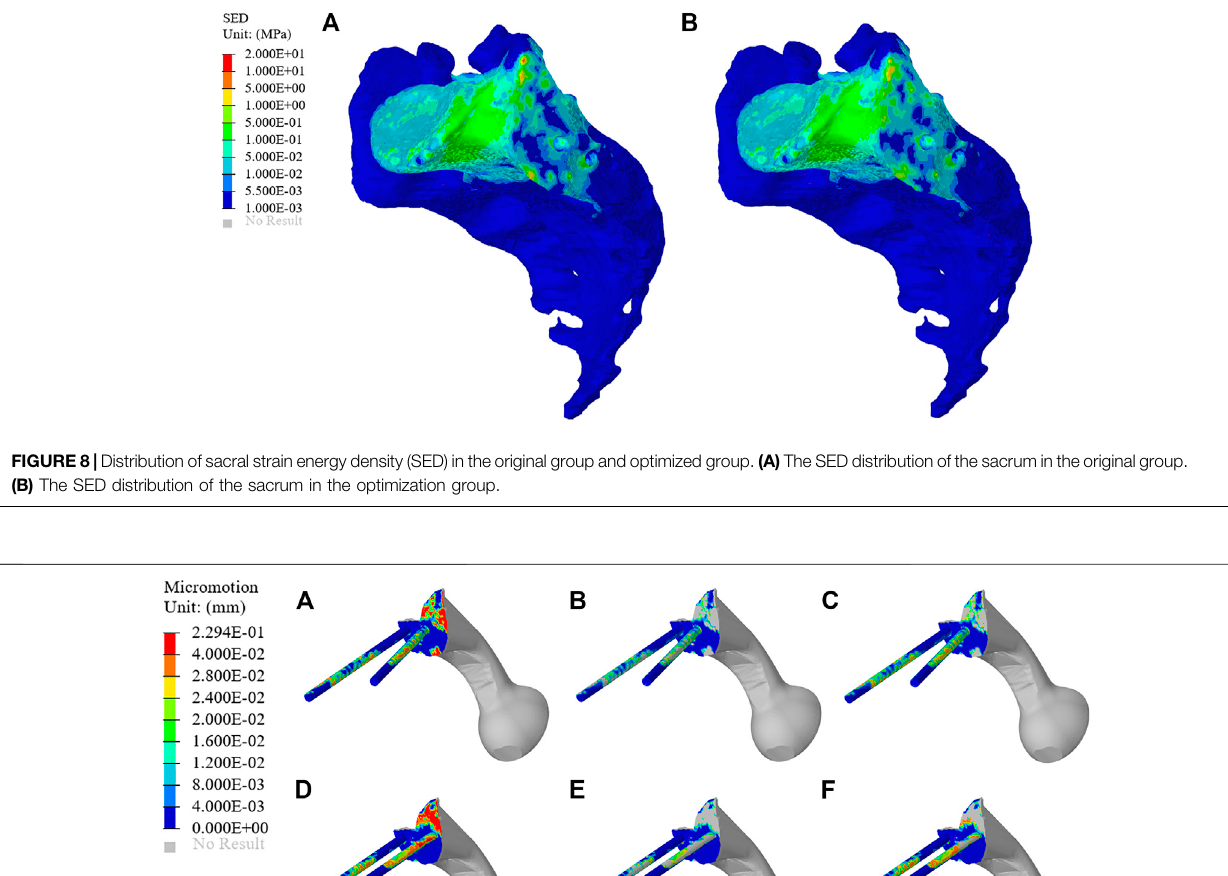
Frontiers in Bioengineering and Biotechnology |